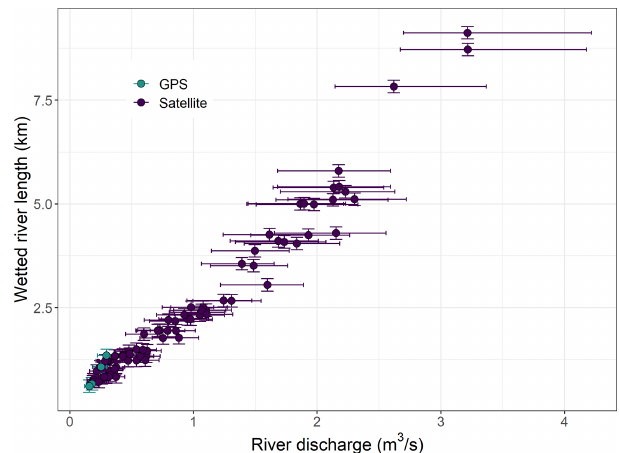
Figure 13. Estimated (empirical distribution, orange) and predicted (simulated distribution, cyan) transmission loss duration curves de- rived for the period between 1 May 2020 and 1 May 2021.